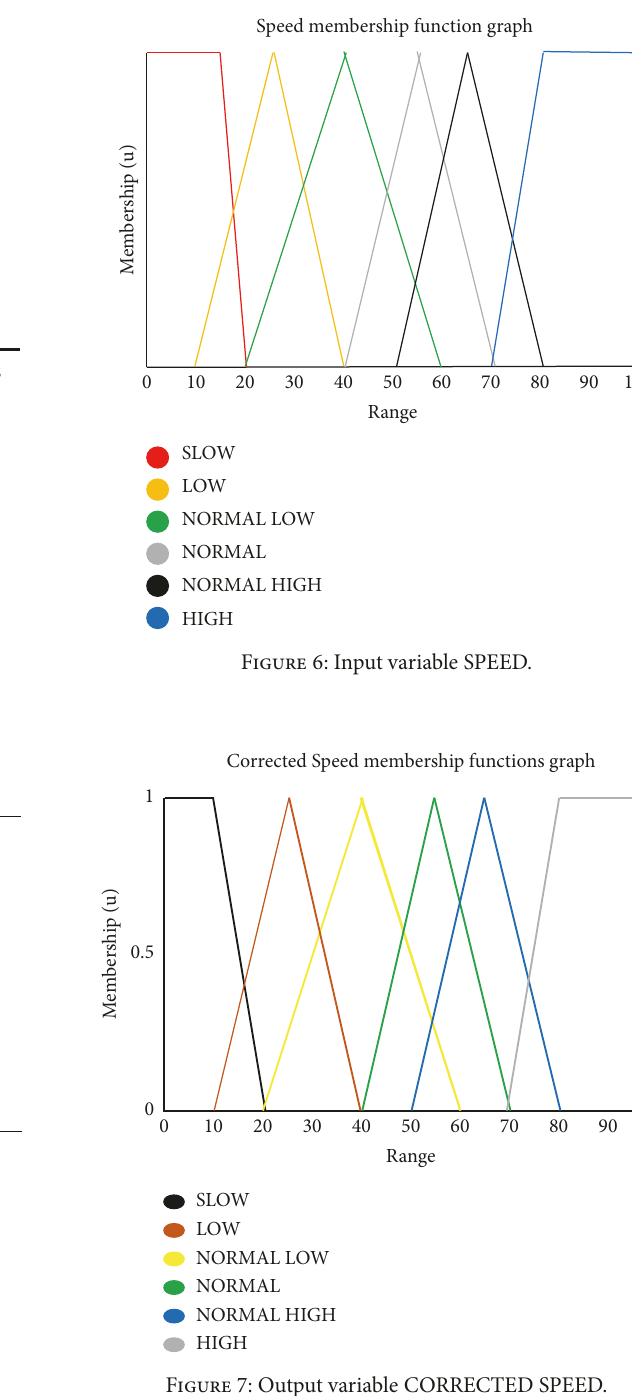
Figure 5: Input variable DEEP OF DISCHARGE.